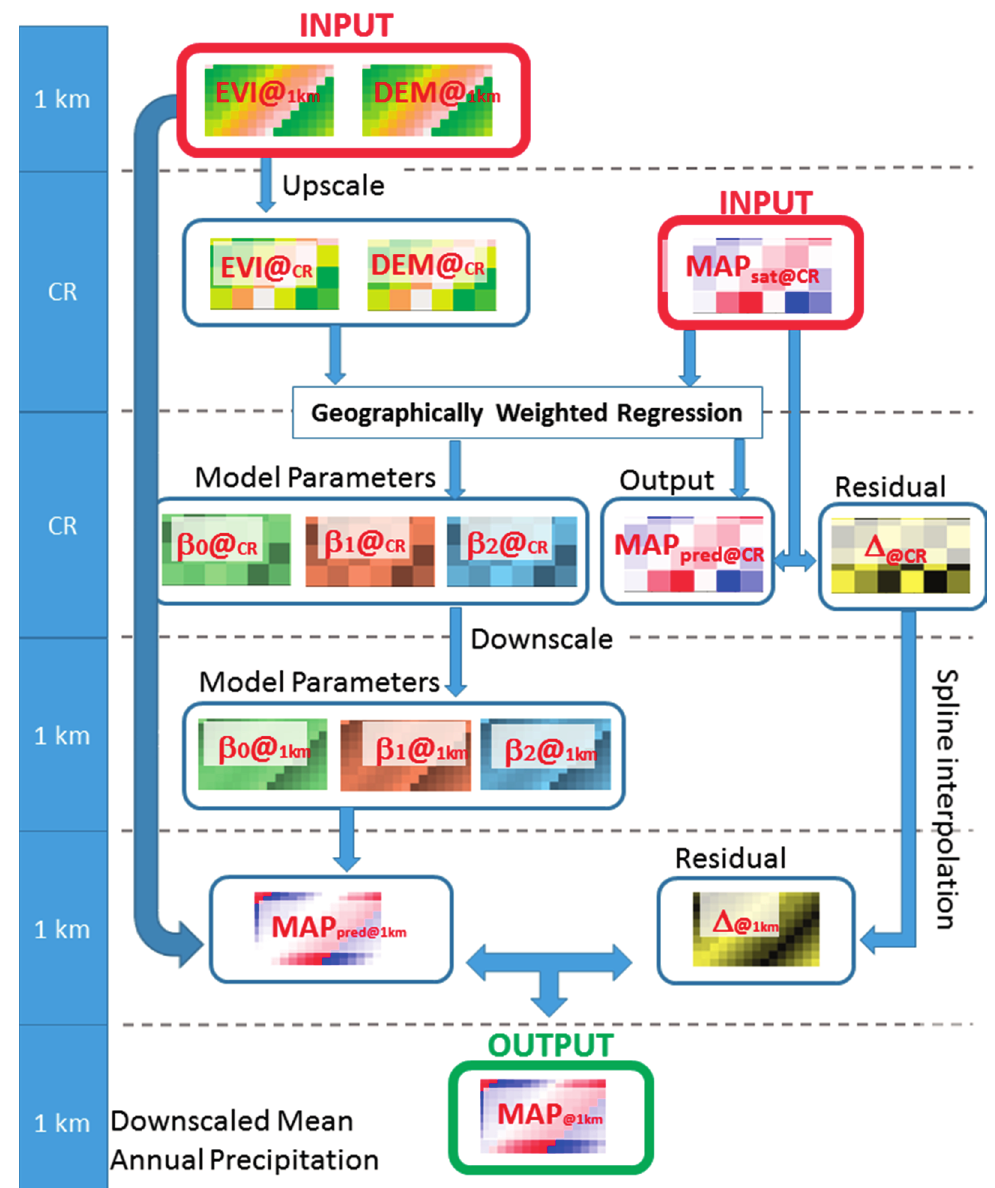
Figure 1. Flowchart of the scheme used to downscale different satellite-based precipitation datasets. CR on the left bar stands for Coarse